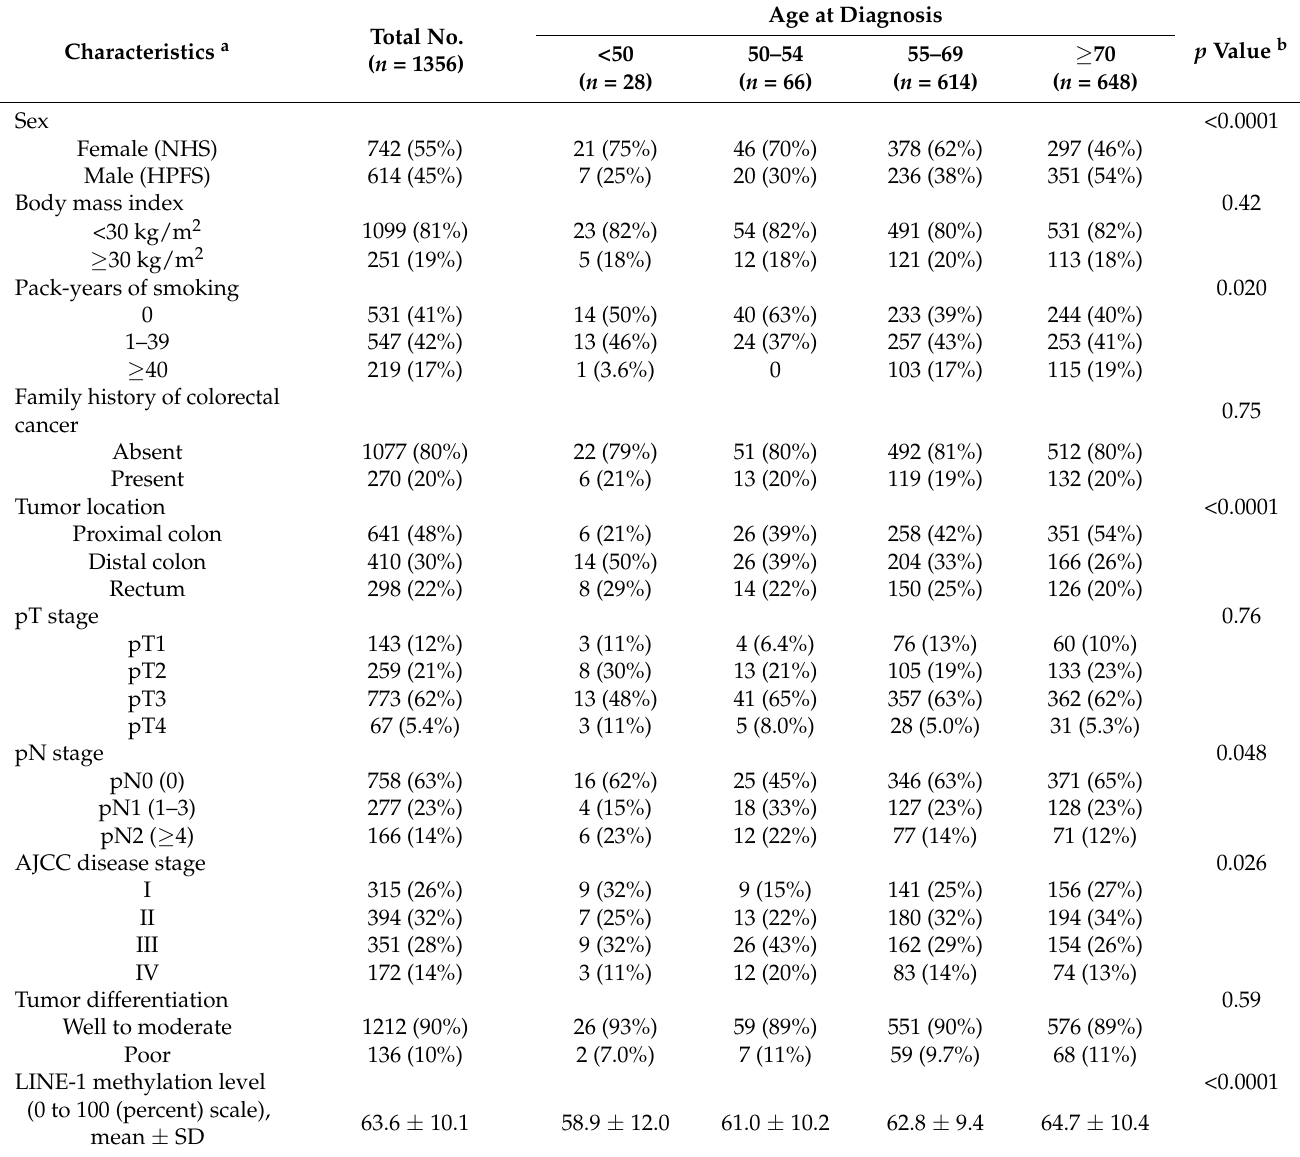
Table 1. Clinical, pathological, and molecular characteristics of colorectal cancer cases according to age at diagnosis. Total No. Characteristics a ( n =